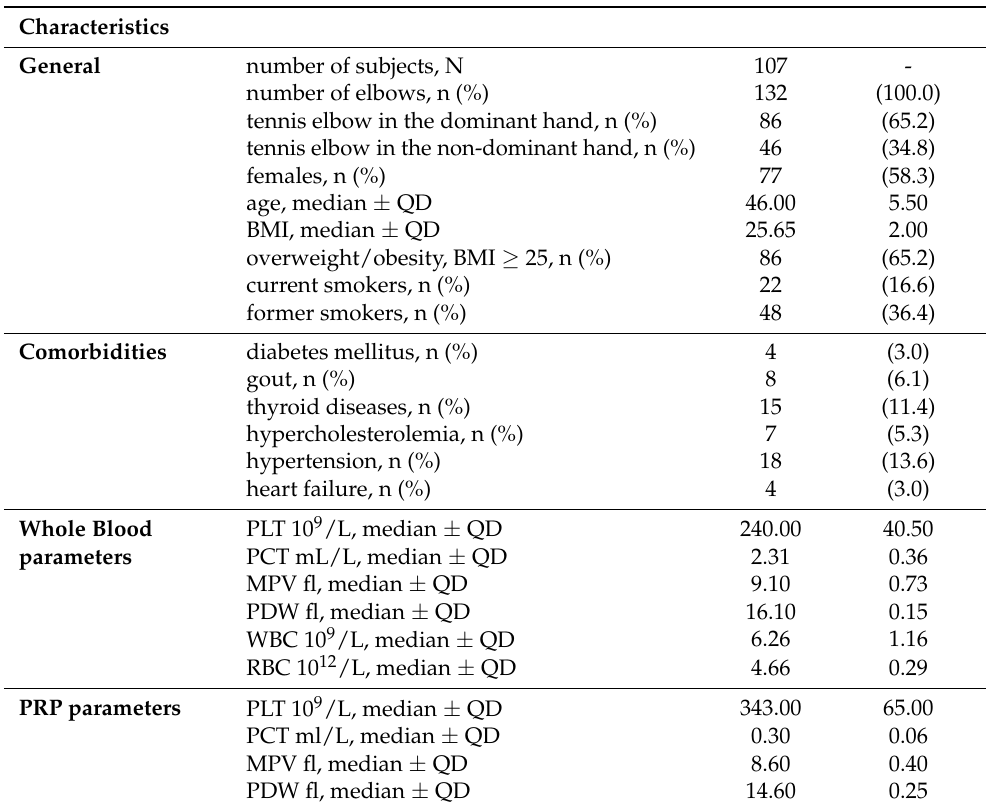
Table 1. Demographic, clinical, and biochemical characteristics of the study group at baseline (baseline week 0).